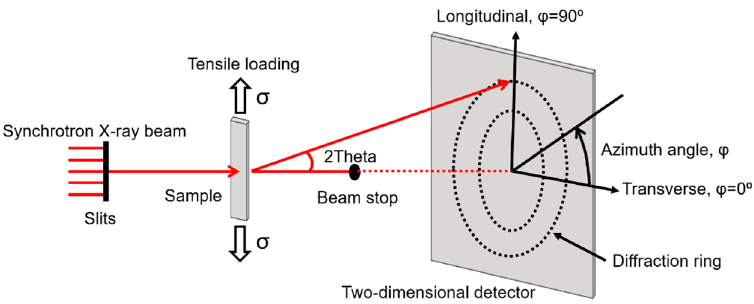
Figure 1. Schematic set-up of in situ synchrotron X-ray experiments.